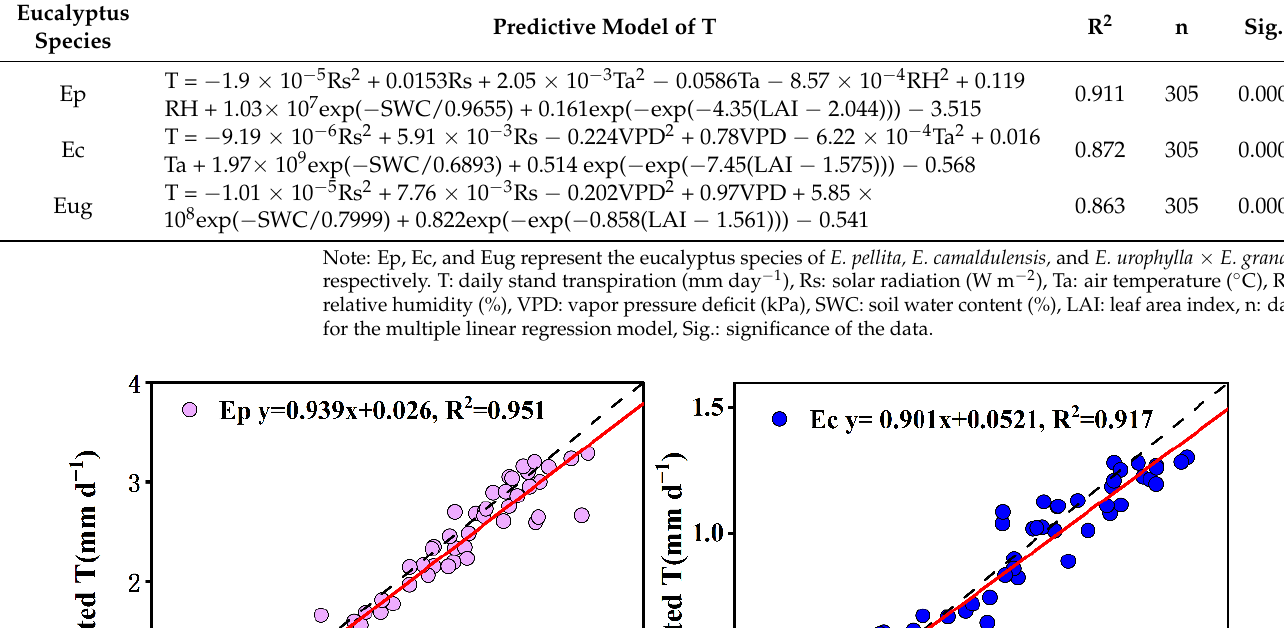
Table 3. The integrated model for predicting daily stand transpiration (T) of three eucalyptus spe- cies.